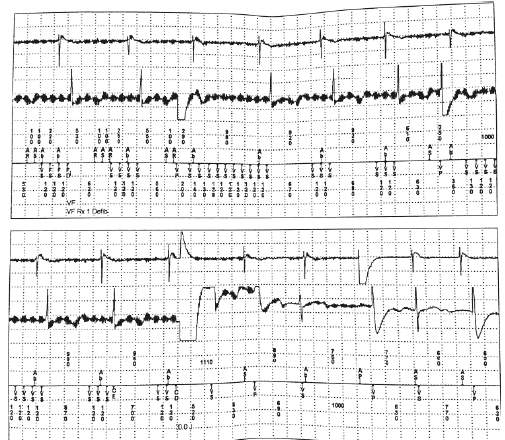
Figure1:Notethehigh-frequency,repetitiveelectromagnetic(EMI) signal, exactly at 120msec intervals. Underlying sinus rhythm and regular QRS complexes are clearly visible. The device inappropri- ately labeled the external AC signal as ventricular fibrillation and cardioverted with 30 J. Ab = atrial blanking period during postven- tricularatrialrefractoryperiod(PVARP);AP:atrialpaced;AR:atrial refractory; AS: atrial sensed; CD: charge delivered; FS: (ventricular) fibrillation sensed; VP: ventricular paced; VS: ventricular